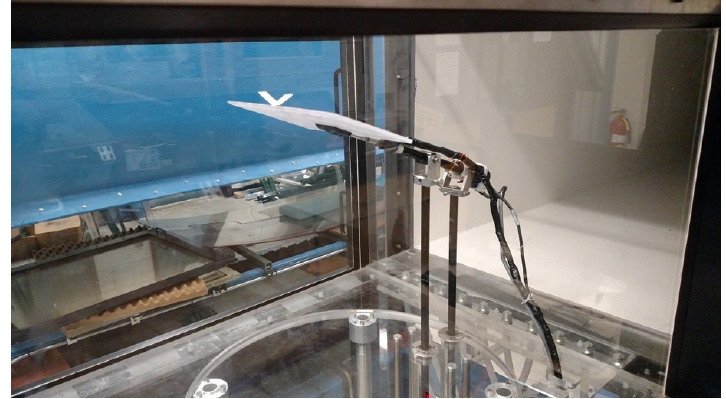
Figure 8. Schematic of the leading-edge alula device adopted by Linehan et al. [22].